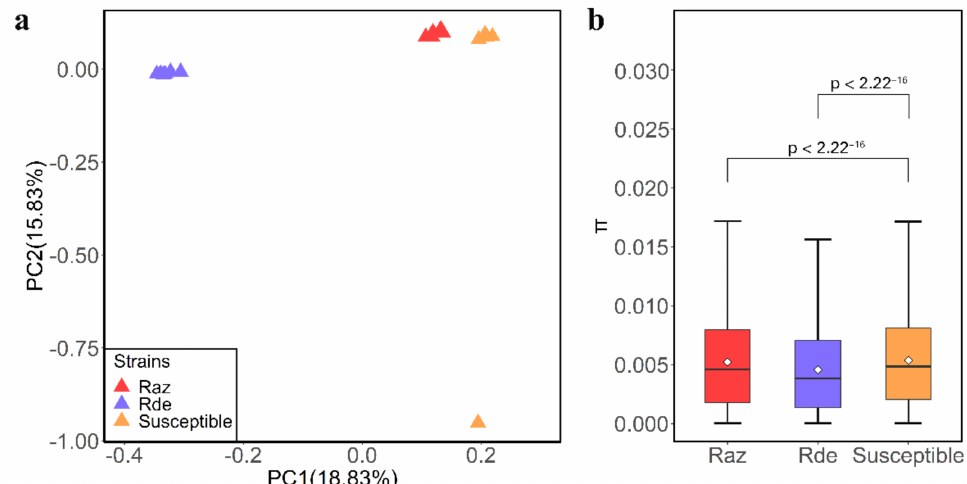
Figure 1. Genetic differentiation between susceptible and resistant (Raz and Rde) strains of C. pomonella. ( a ) Principal component analysis (PCA) of SNPs. The red and purple triangles represent the samples resistant to azinphos-methyl (Raz) and deltamethrin (Rde), and orange triangles represent the samples susceptible to azinphos-methyl and deltamethrin (S). ( b ) Boxplot showing the population nucleotide diversity ( θπ ) of the three stains of C. pomonella ( t -test, p < 2.22 × 10 − 16 ), indicating minimum, low quartile, median, mean, high quartile, and maximum values.